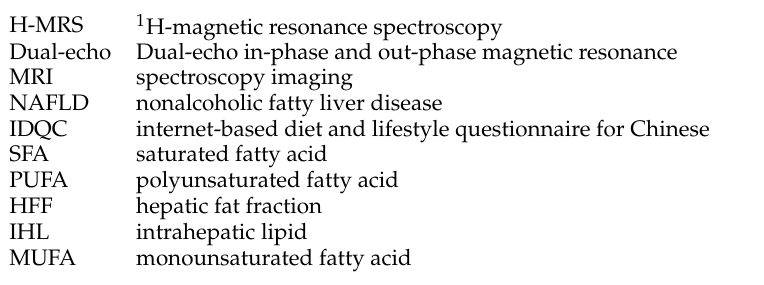
Table S1: Dietary standardized values of the nutrients, Table S2: Associations between dietary standardized